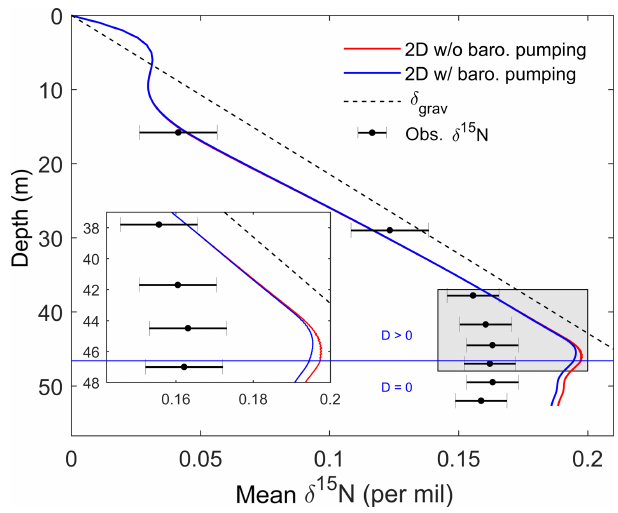
Figure 10. Horizontally averaged δ 15 N at Law Dome DSSW20K. The solid lines show the results of the 2-D model (with layers) for the cases with (blue) and without (red) barometric pumping. Black circles with error bars indicate the observed firn δ 15 N (Trudinger et al., 2002, 2013). The dashed black line represents the equilibrium solution for pure gravitational settling ( δ grav ). The horizontal blue line marks the depth where vertical diffusivity reaches zero. The inset shows a magnification of the lock-in